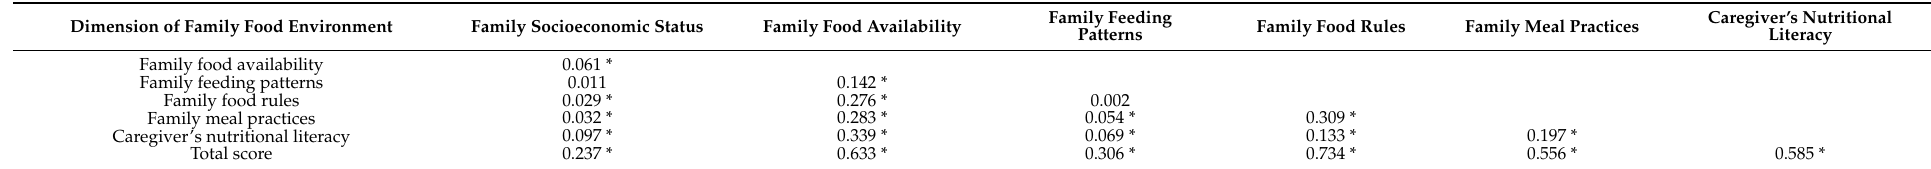
Table 2. Partial correlation between family food environment